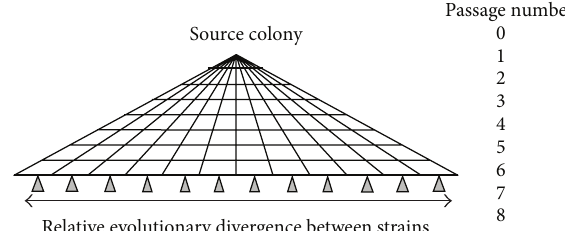
Figure 1: A schematic diagram of the experimental design. Theo- retical accumulation of mutational variations among the 12 bacterial culture